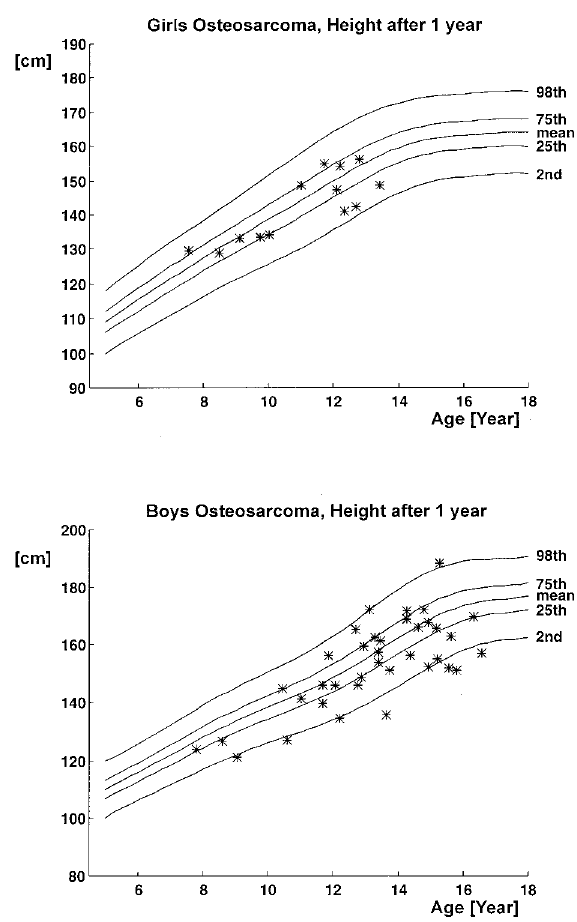
Fig. 2. Height at diagnosis in 63 children with an osteosarcoma Fig. 3. Height 1 year following diagnosis in 50 children who in the area of the knee plotted in the growth charts for the normal received neo-adjuvant chemotherapy for an osteosarcoma in the population. 14,15 area of the knee plotted in the growth charts for the normal population.